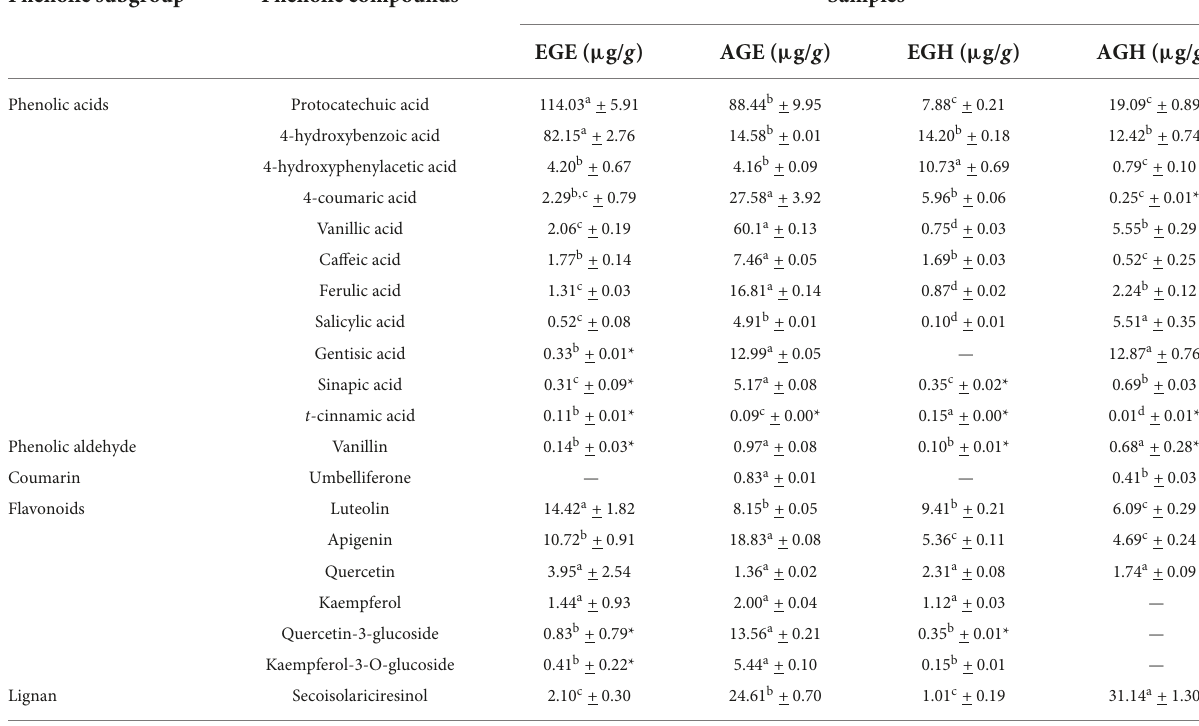
TABLE 3 Identification and quantification of phenolic compounds in early grasshopper extract (EGE), adult grasshopper extract (AGE), early grasshopper hydrolysate (EGH), and adult grasshopper hydrolysate (AGH). Phenolic